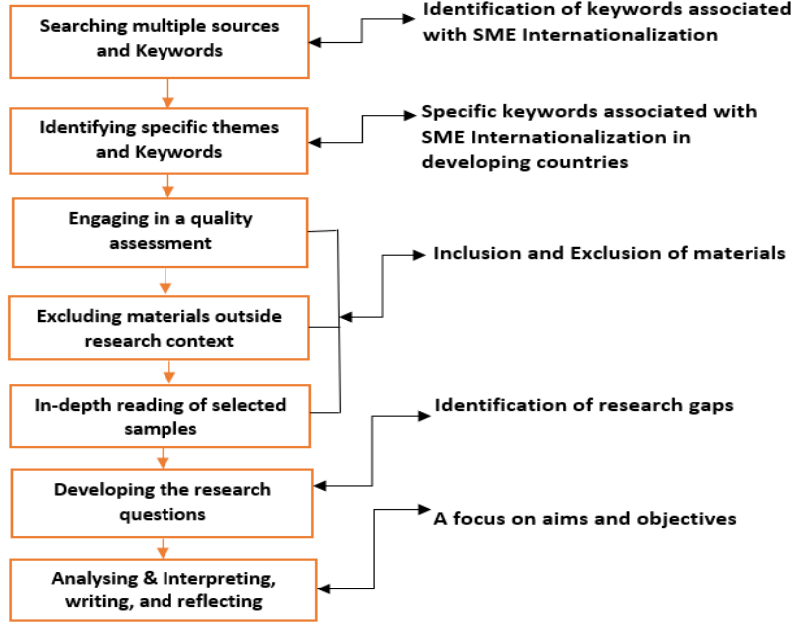
Figure 2. The Process of the systematic Review.